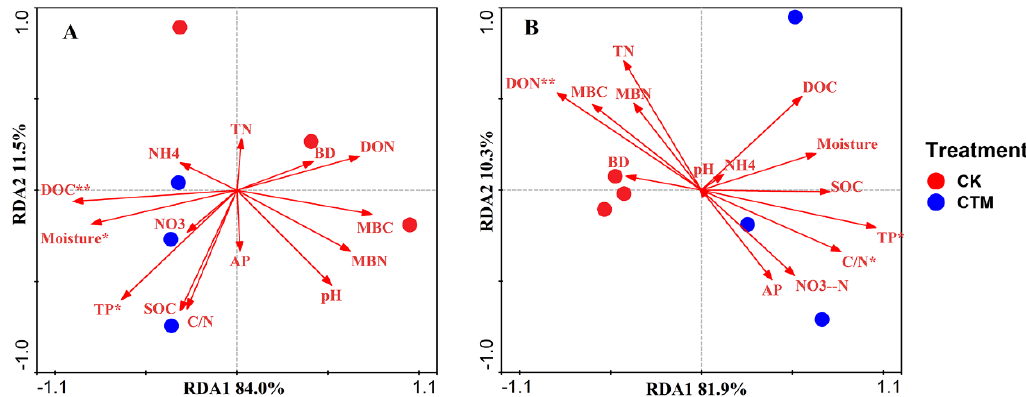
Figure 6. RDA of soil bacterial ( A ) and fungal ( B ) communities at the genus level and soil physical and chemical properties. BD, bulk density; SOC, soil organic carbon; TN, total nitrogen; TP, total phosphorus; AP, available phosphorus; NO 3 − -N, nitrate nitrogen; NH 4+ -N, ammonium nitrogen; MBC, microbial biomass carbon; MBN, microbial biomass nitrogen; DOC, dissolved organic carbon; DON, dissolved organic nitrogen; * p < 0.05; ** p < 0.01. Table 3. Mantel test results for the correlation between microbial community composition and soil factors at the genus level. Soil Variable